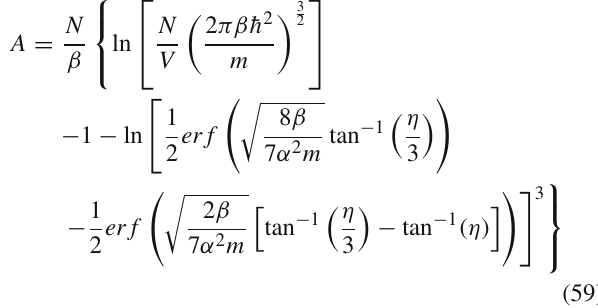
Fig. 1 Behavior of the chemical potential of an ideal gas, μ , versus β for both the classical and deformed theory. The solid thick curve repre- sents the chemical potential in the classical theory. The other curves are corresponding results in the deformed theory with natural cutoffs for different values of the parameter α = 0 . 2 , 0 . 3 , 0 . 4 , 0 . 5, from bottom to top, respectively. In this plot and other ones in this paper we have set N = 10 , 000 and V , ¯ h , K B , m are set equal to unity for the sake of simplicity in numerical